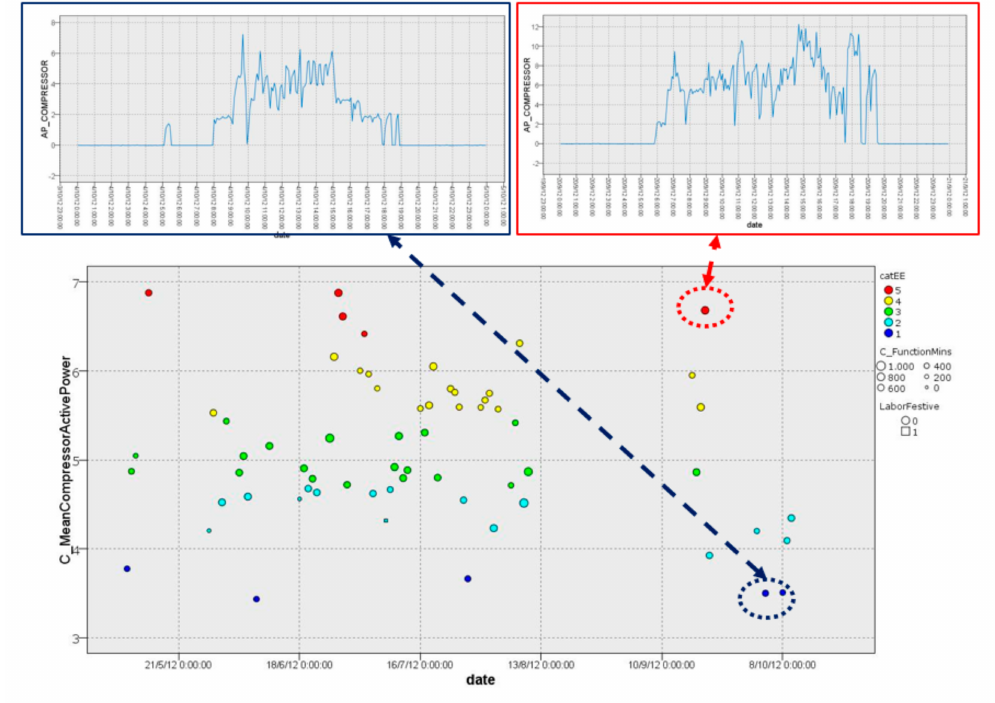
Figure 12. EE category prediction for cluster 3.3 and energy consumption